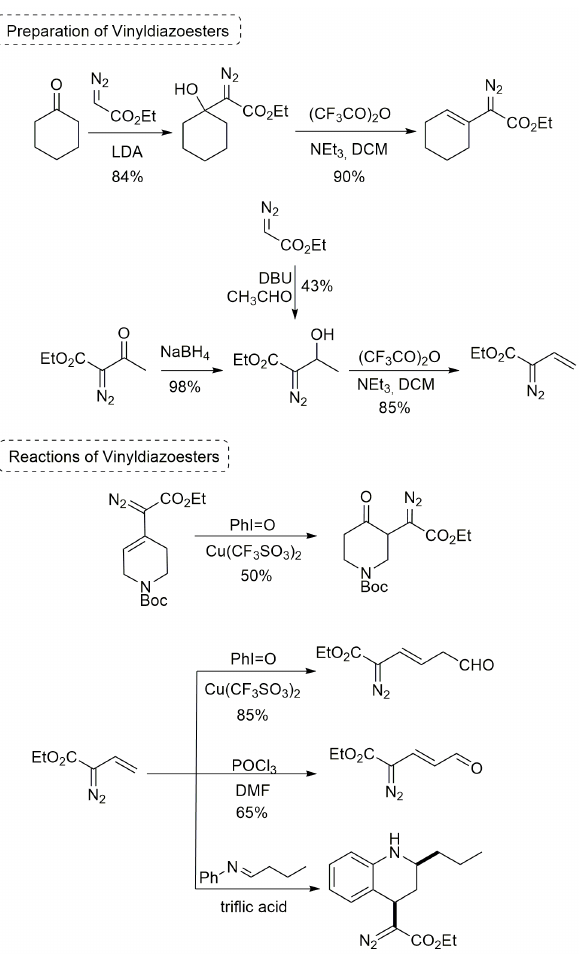
Figure 57 - Preparation and reaction of